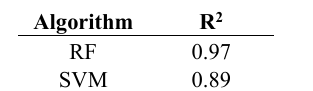
Table 2. Comparison of different algorithms coefficient of determination.